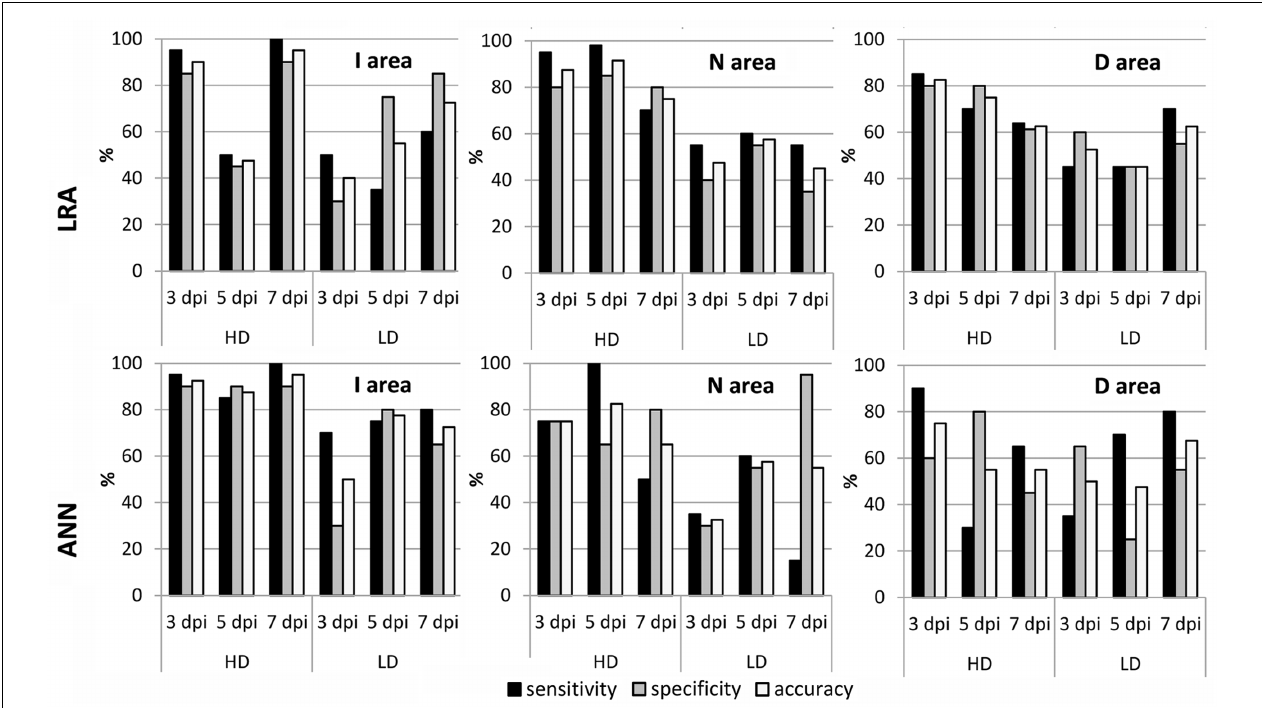
FIGURE 4 | Sensitivity, specificity, and accuracy of the best fits obtained by LRA and for the best ANN for the I, N, and D areas of zucchini leaves LD and HD-inoculated with D. dadantii .